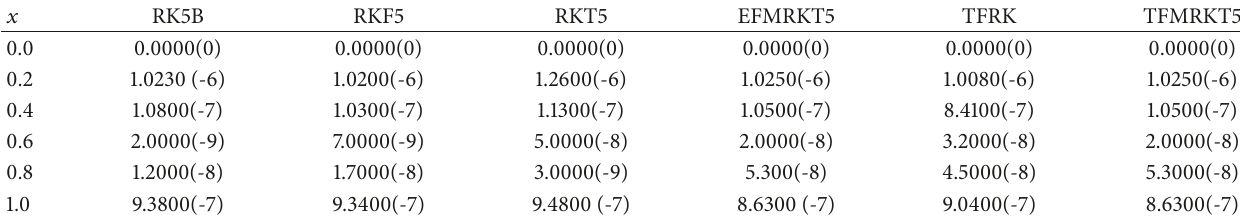
Table 6: Comparison of error for problem in thin film flow (58) taking ℎ = 0.1 and 𝑘 = 2 .